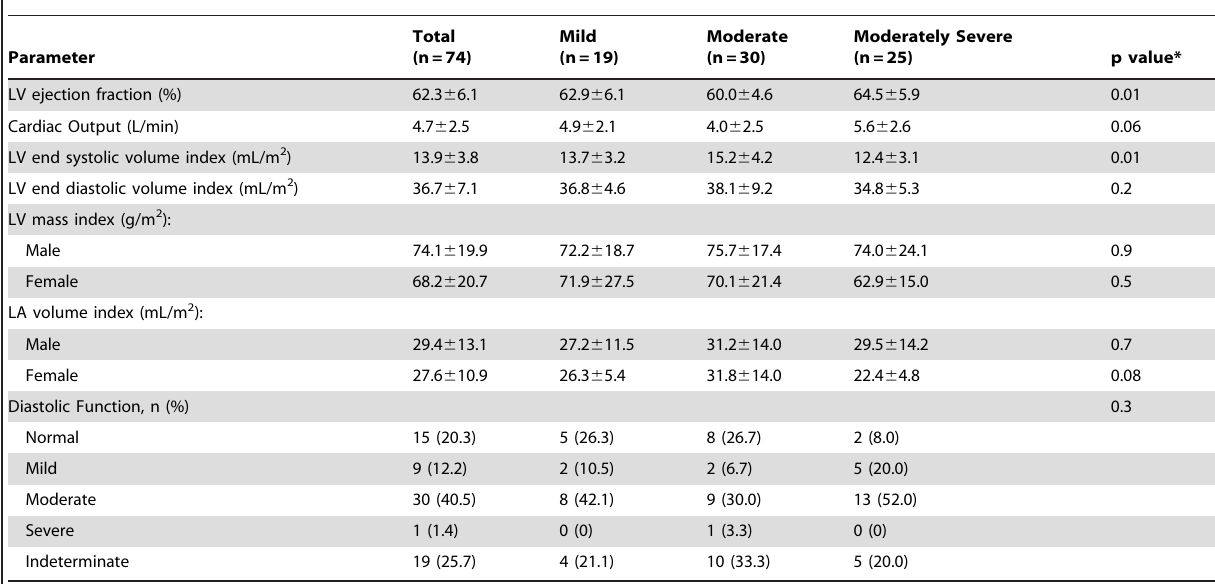
Table 3. Left Heart Parameters by COPD